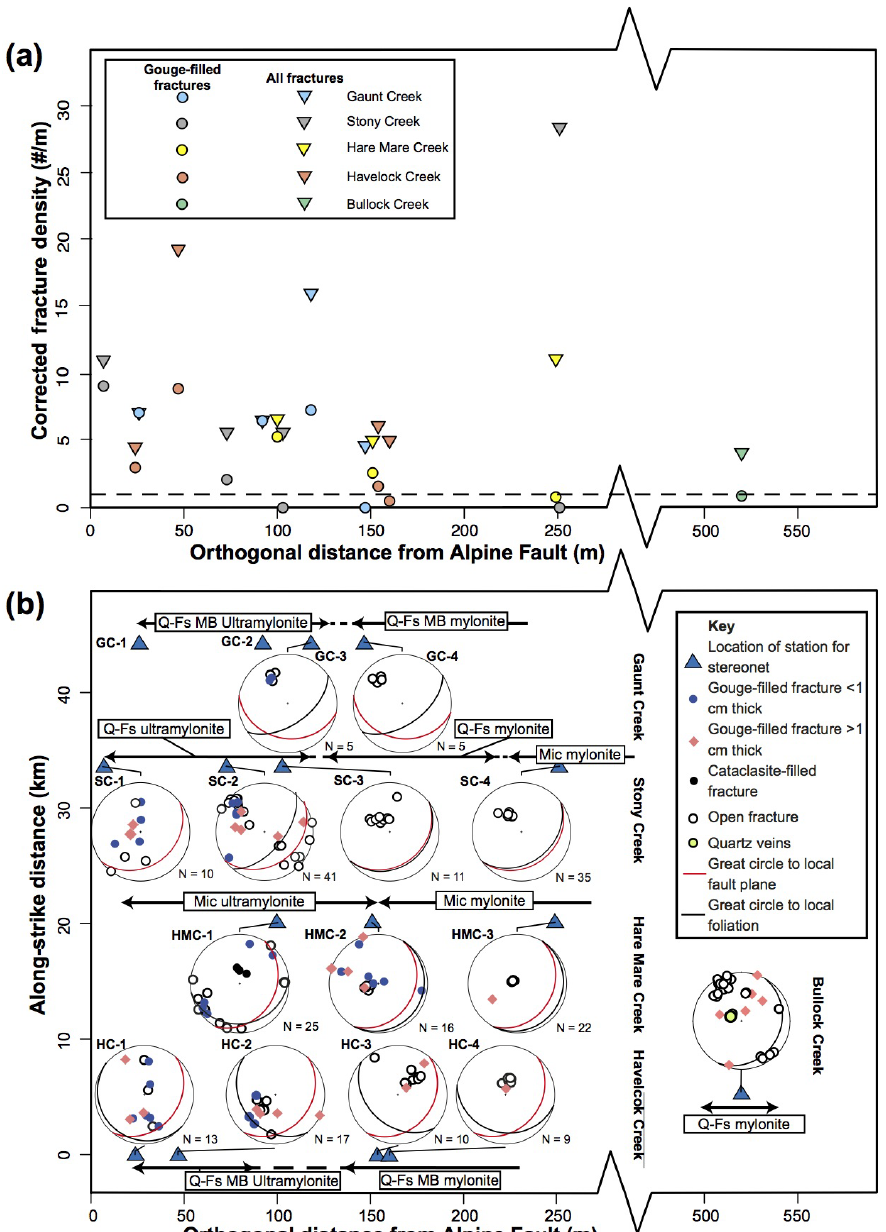
Figure 7. (a) Corrected fracture density at all stations for gouge-filled fractures and all fractures. The dashed line indicates a corrected fracture density of 1fracturem − 1 . No orientation data were collected at Gaunt Creek stations 1 and 2, so fracture density is calculated from the two perpendicular transects. (b) Compilation of stereoplots for fracture orientations at each field station. Stations have been plotted as a function of distance from the fault and distance along strike (with respect to Havelock Creek) along within fault rock lithologies (Toy, 2008). Dashed lines indicate gradational or obscured lithological boundaries. Qf:, quartzofeldspathic; MB: metabasic; Mic: micaceous. For field cross sections and location of stations, see Fig. S1 and Table